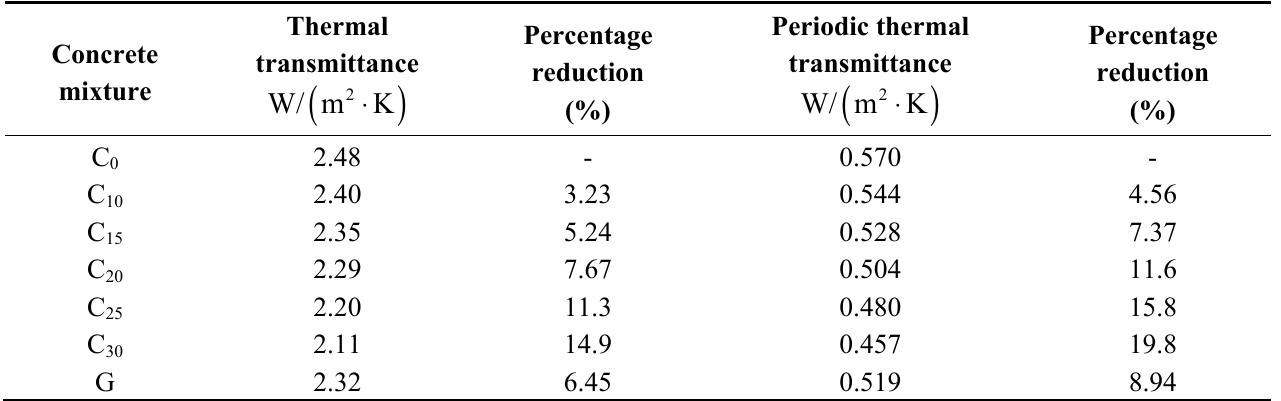
Table 7. Thermal transmittance and periodic thermal transmittance of the slab reported in Figure 3.